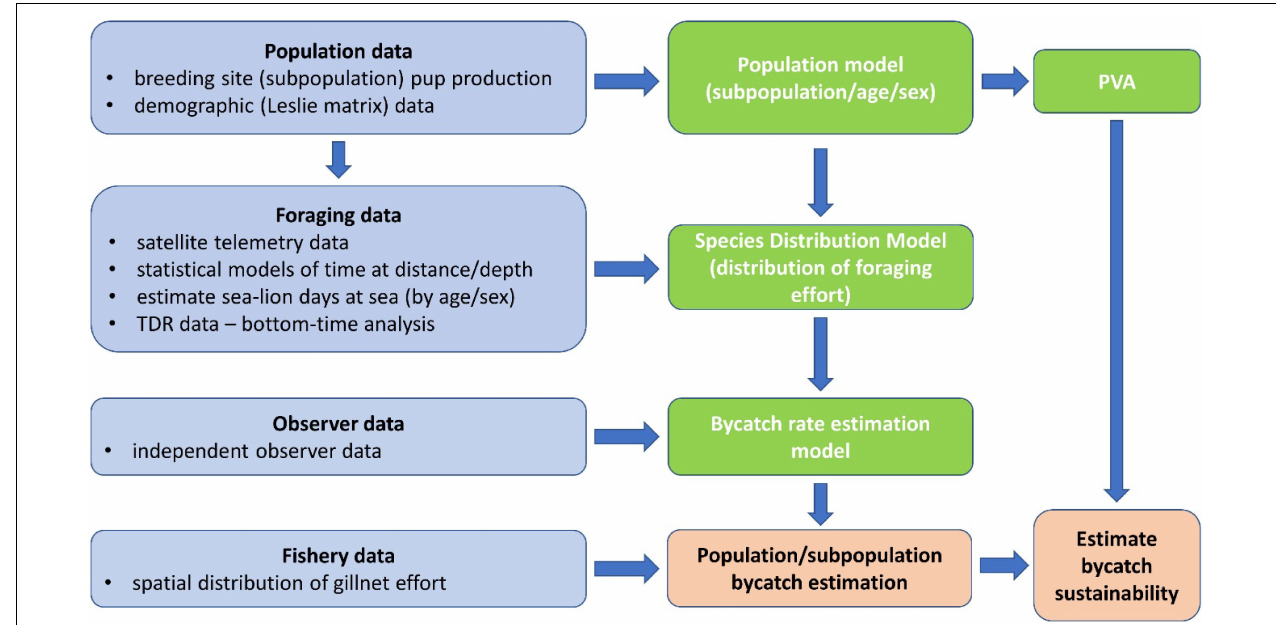
FIGURE 1 | Schematic representation of the various components of data used, and the steps undertaken to develop the suite of models (population, species distribution and bycatch rate estimation models) used to estimate the bycatch mortality of ASL and its impact on population